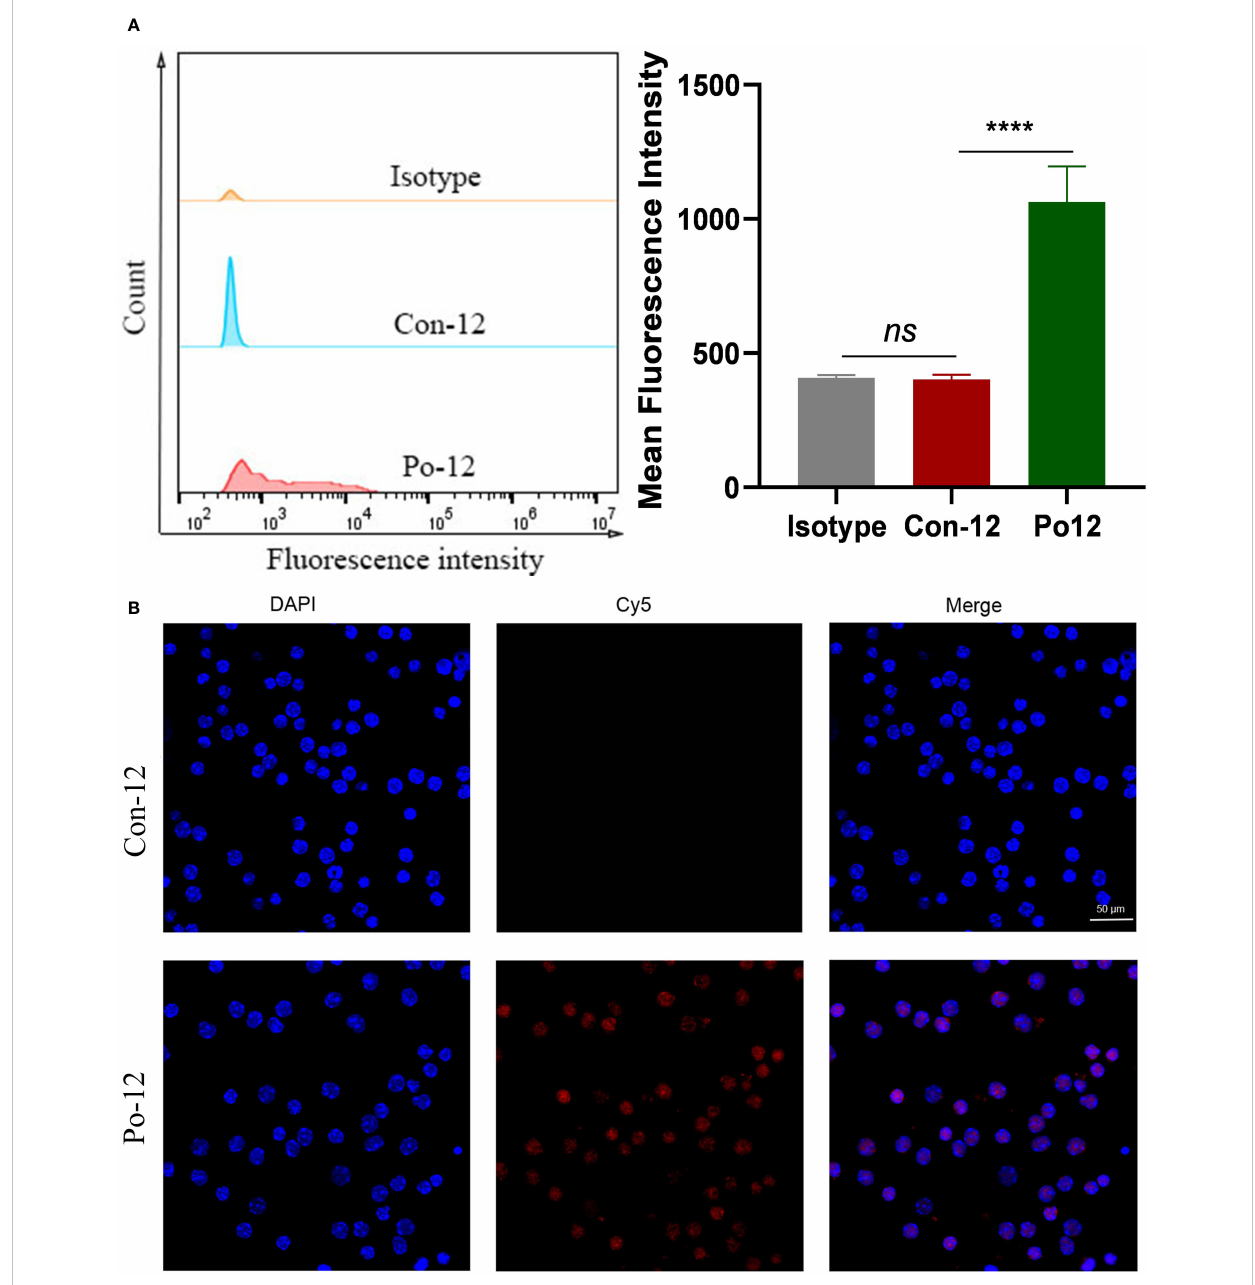
FIGURE 4 Binding of TIGIT-targeted peptide to lymphocytes. (A) FCM analysis of lymphocytes after incubation with Con-12-Cy5 or Po-12-Cy5 peptide (n=3). (B) Confocal images of lymphocytes after treatment with Con-12-Cy5 or Po12-Cy5 peptide. Scale bar: 50 m m. ns, no signi fi cance; **** P <